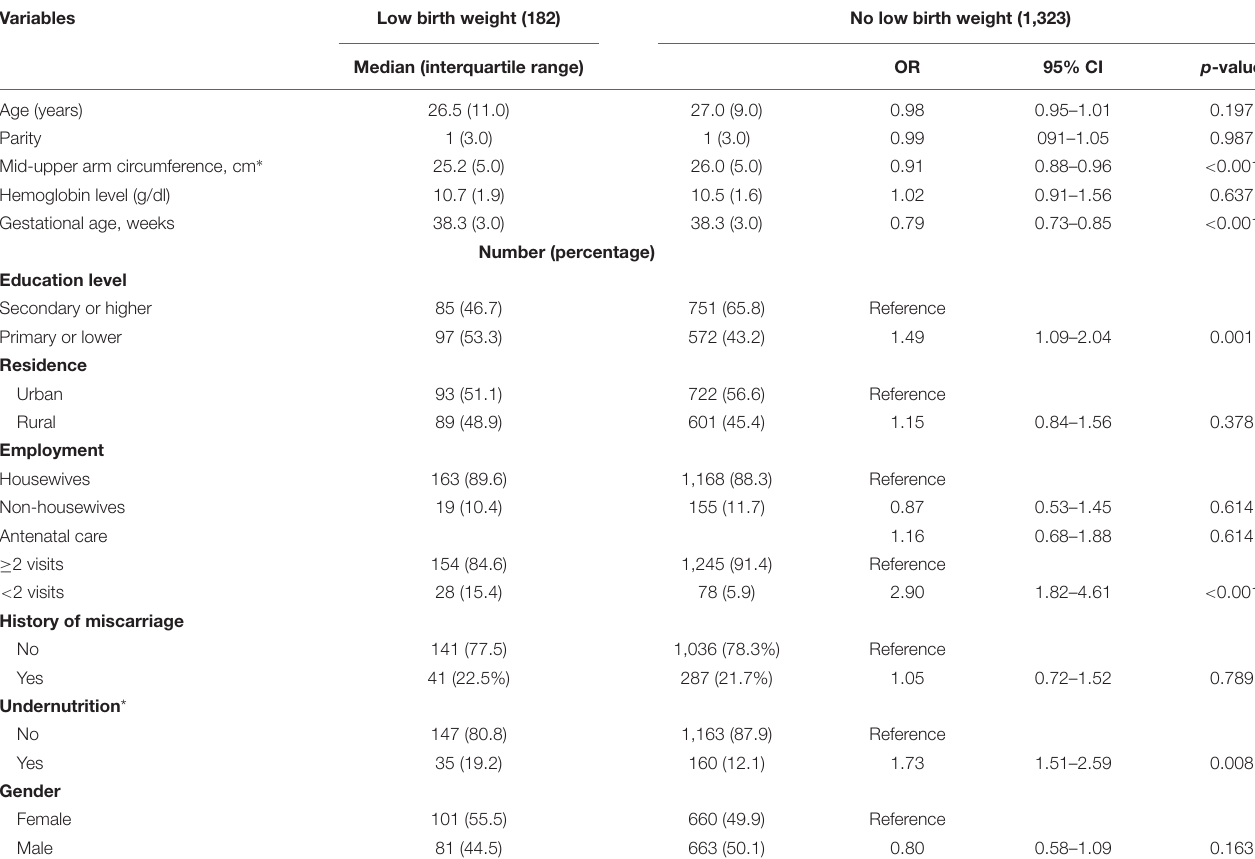
TABLE 1 | Univariate analysis of the factors associated with low birth weight in Khartoum, Sudan, 2020.